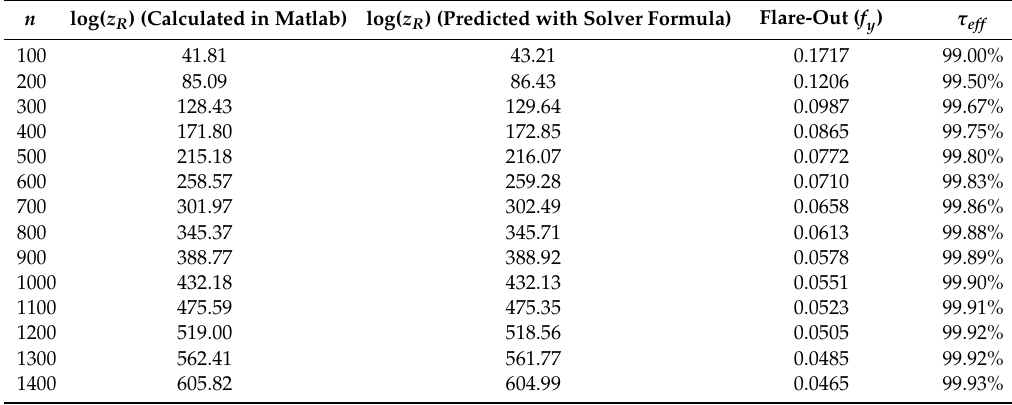
Figure 9. Log( 𝑧 (cid:3019) ) vs. iterations.